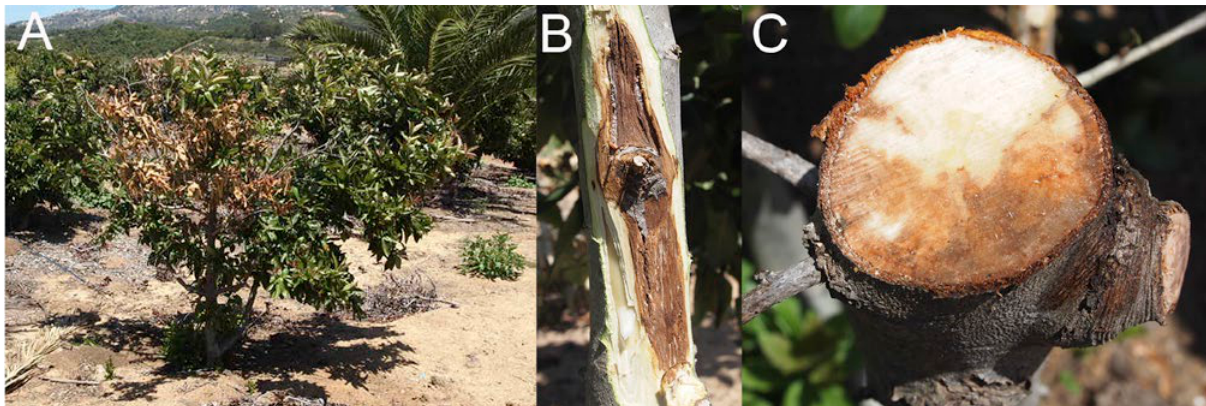
Figure 1. (a) A tejocote tree showing dieback, (b) canker on the trunk, and (c) cross section of a branch